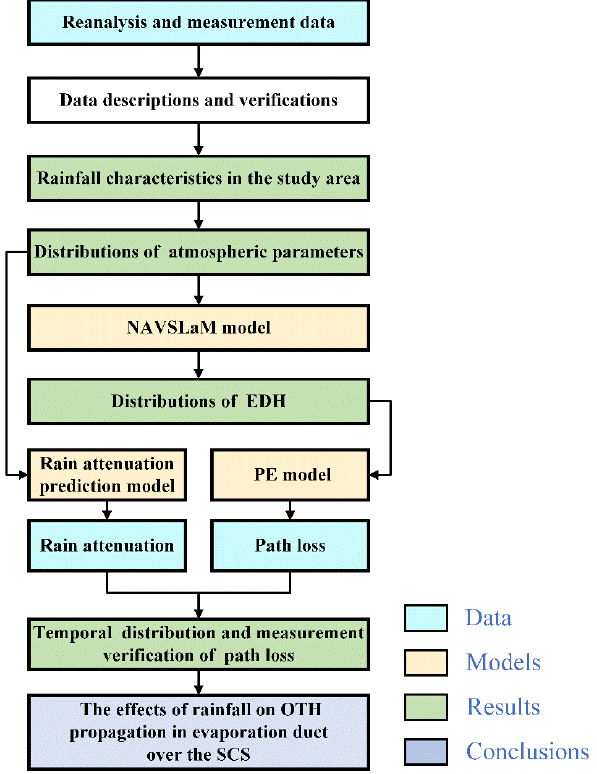
Figure 1. The flowchart for this study.